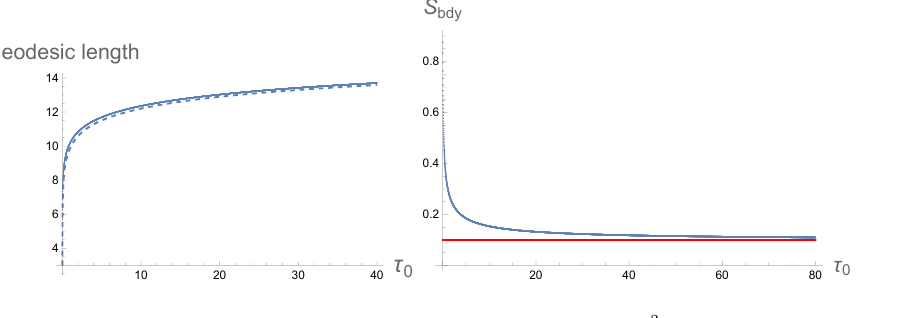
case and plot of log (2 τ 0 /(cid:15) ) 1+ τ